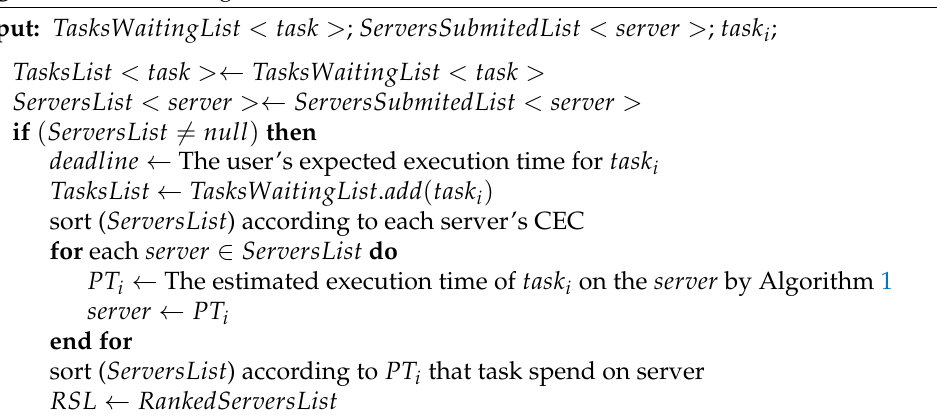
Algorithm 2 DSOTS